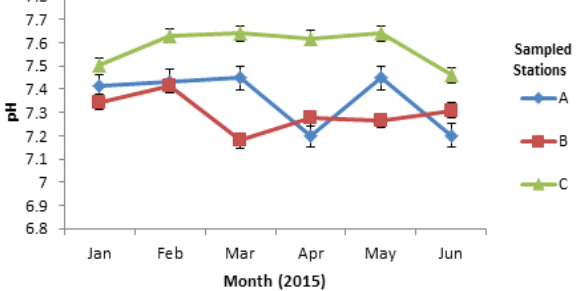
Fig. 4. The monthly mean variation of water pH of the water sampled from Saba River